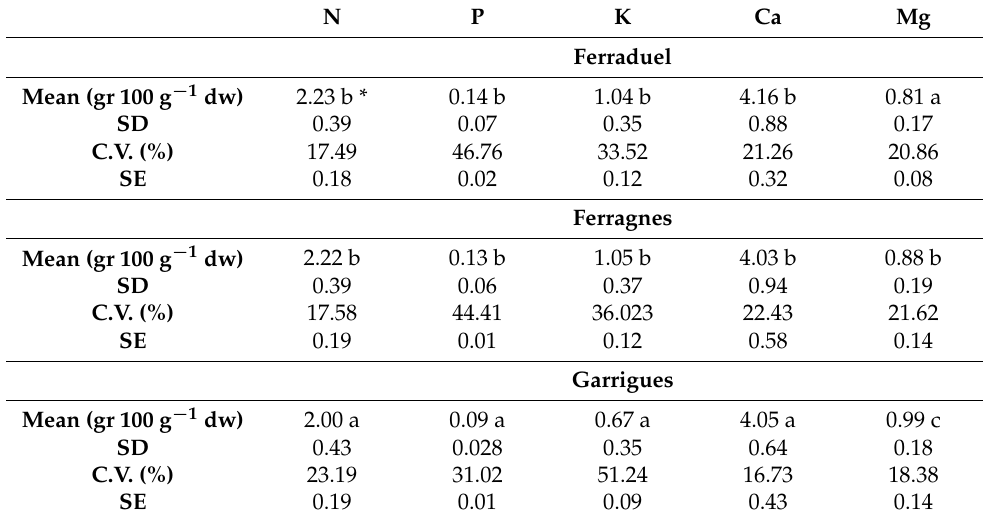
Table 1. Mean values of leaf macronutrient concentration in July for the Ferraduel, Ferragnes, and Garrigues varieties. Leaf concentration is expressed as a percentage (mg 100 mg − 1 dw).